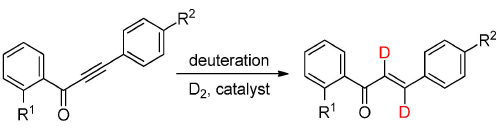
Scheme 1. The proposed synthesis of deuterium-labeled